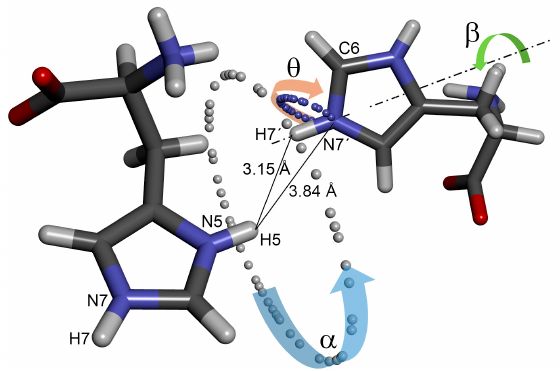
Figure 3. Definition of the three rotational angles resulting from geometric constraints; d(H5···H7’) = 3.15 Å, d(H5···N7’) = 3.44 Å and d(N5···H7’) = 3.84 Å.